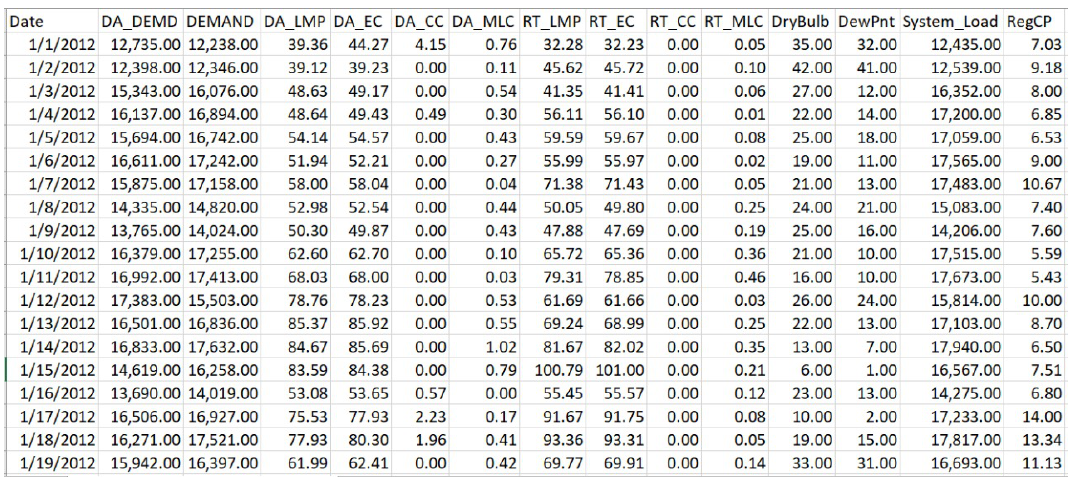
Figure 4. Dataset Overview (Features and